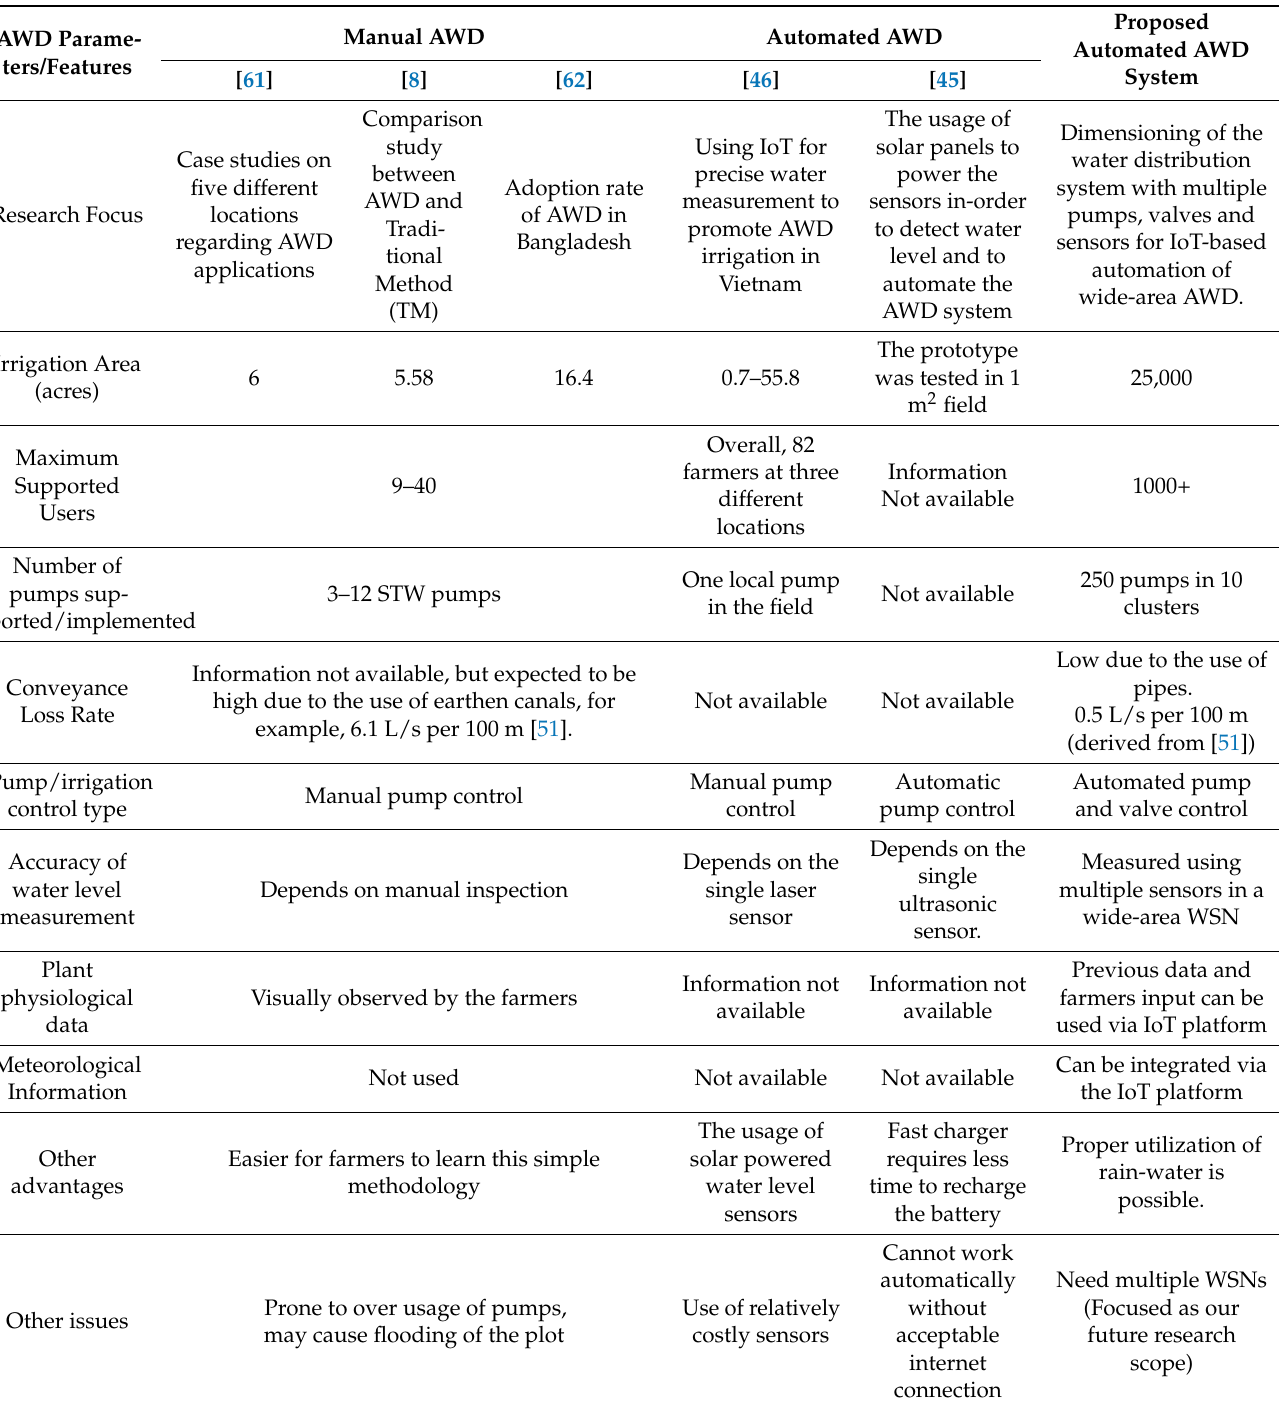
Table 4. Comparison between manual AWD and automated